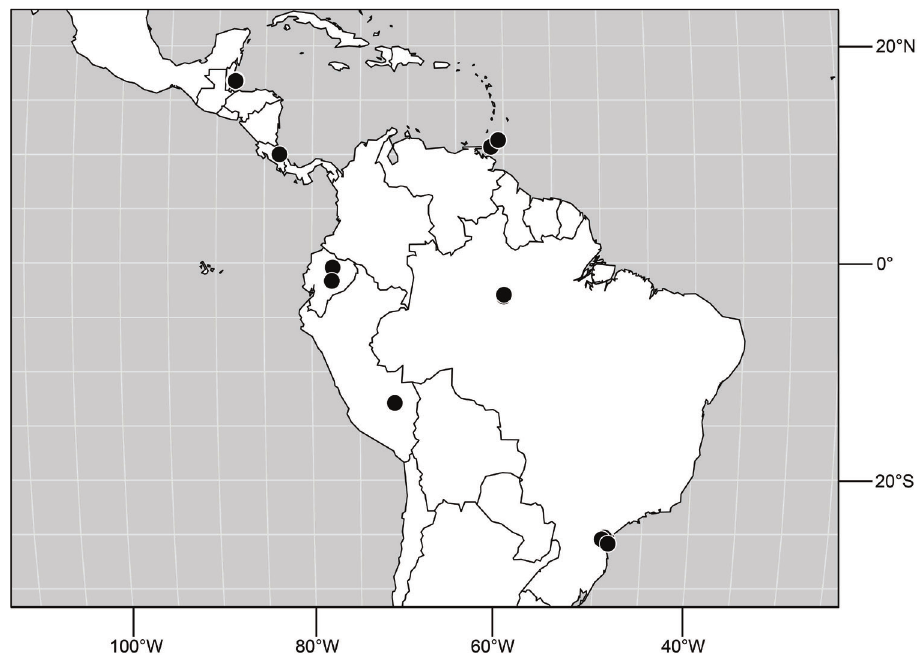
Figure 195. Distribution of Hydrochasma sagittarium sp.